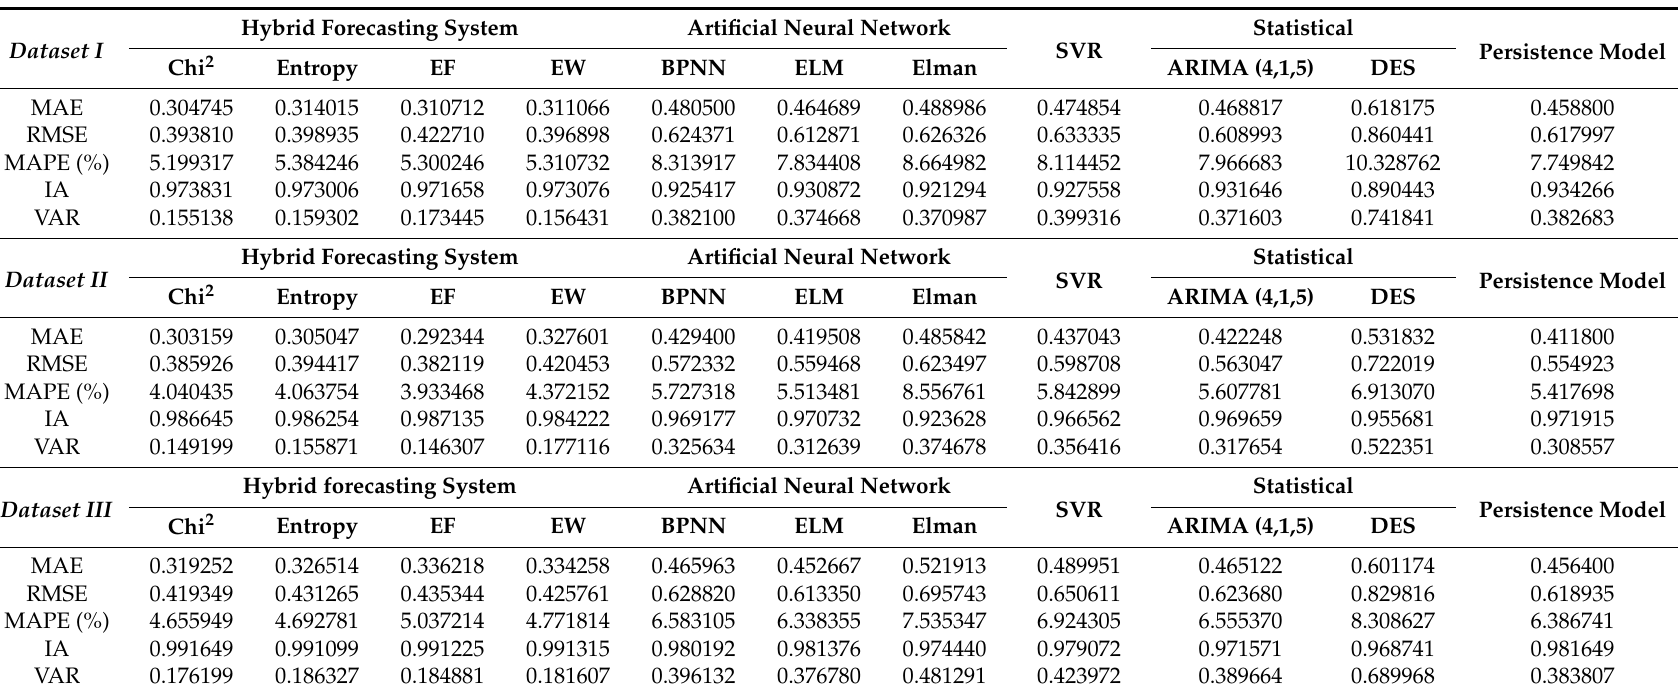
Table 9. Comparison of the hybrid forecasting system against artificial intelligence, statistical, and persistence